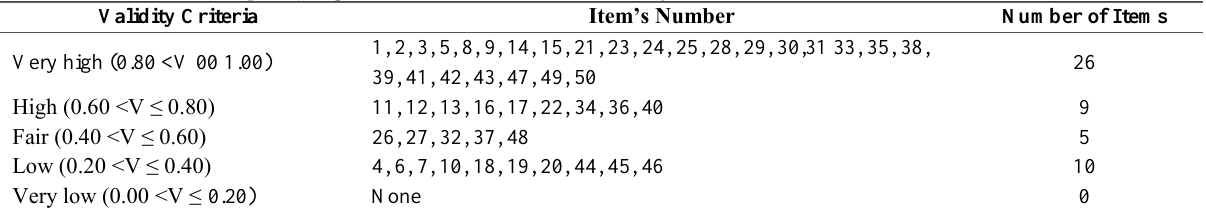
Table 2 The result of expert judgment based on content validity